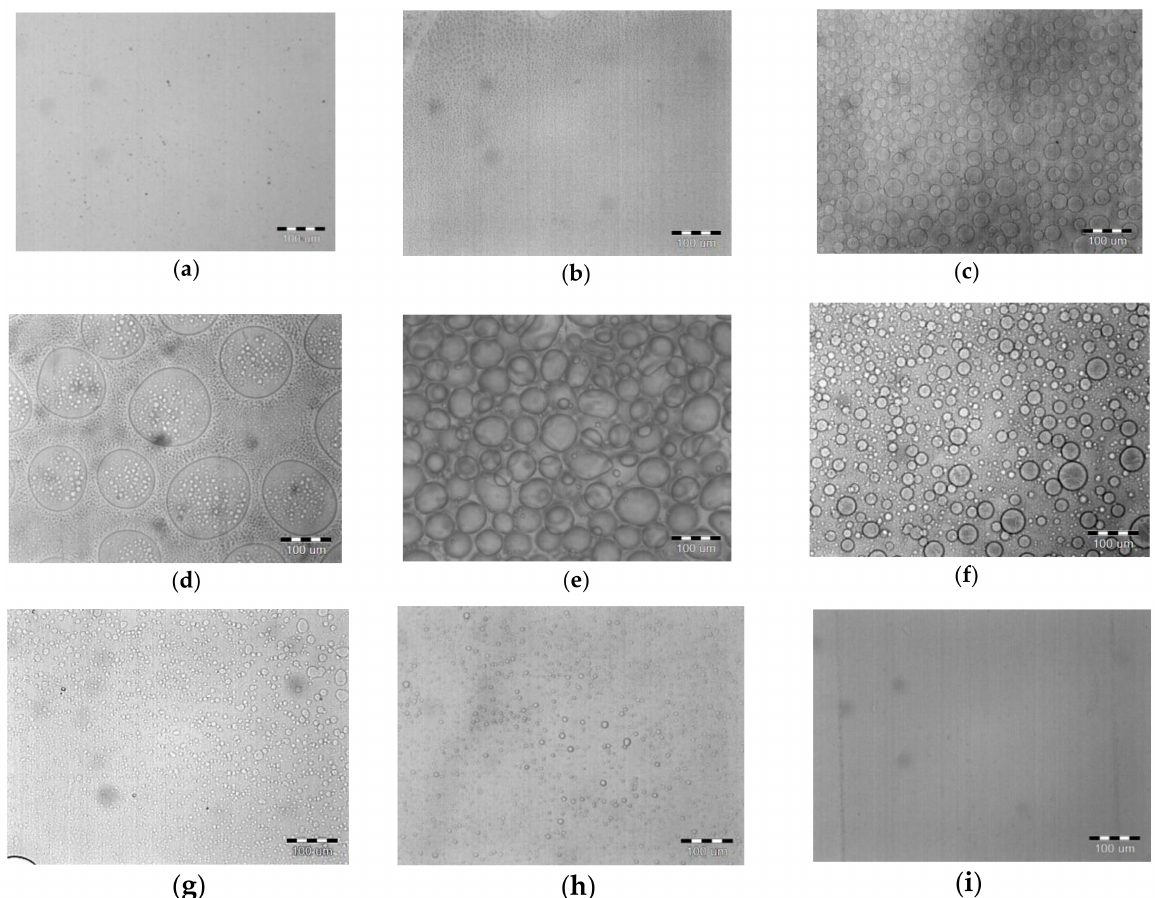
Figure 5. Optical microscopy photographs of PPSU/PSF blend solutions in NMP after keeping 18 h between two glass slides, PPSU:PSF blend ratio: ( a )—0:100; ( b )—10:90; ( c )—30:70; ( d )—40:60; ( e )—50:50; ( f )—60:40; ( g )—70:30; ( h )—90:10; ( i